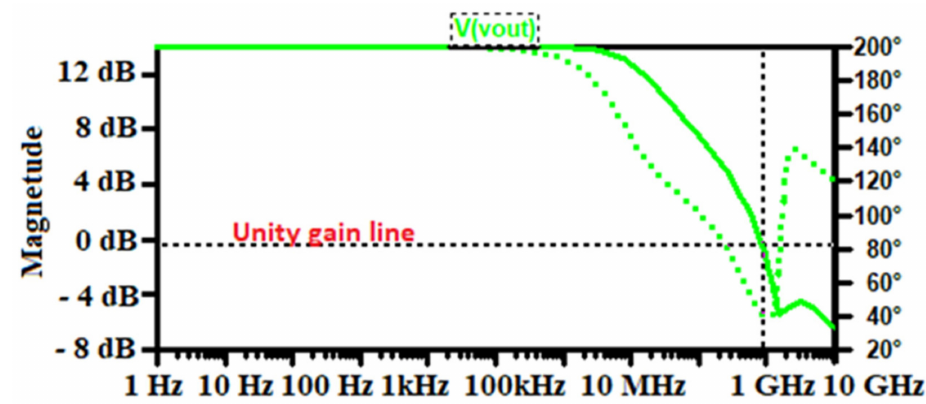
Figure 8. Bandwidth compensation using feedback lead network-based a MOSFET resistor; which allows achieving high